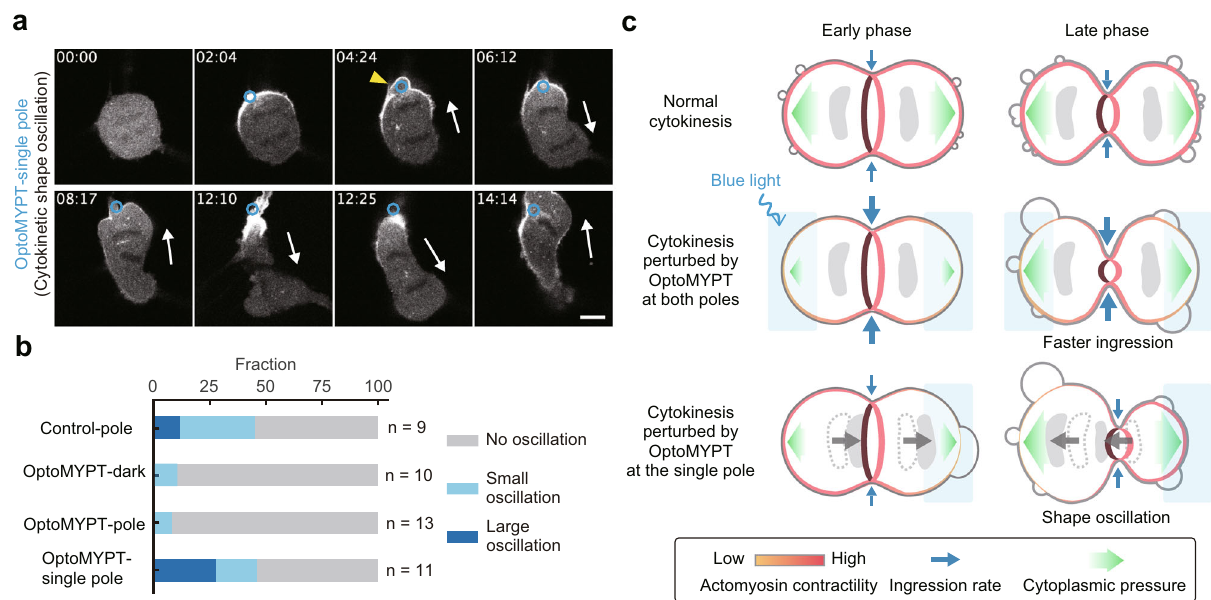
Fig. 5 OptoMYPT induced shape instability during cytokinesis. a Representative images of SspB-mScarlet-I-MYPT169 during cytokinesis upon illumination to the single pole. The blue circular regions were locally illuminated with blue light every 3.11 s. The yellow arrowhead and white arrow indicate a large bleb just before spindle oscillation and the direction of chromosome motion, respectively. Scale bar, 10 μ m. b Quanti fi cation of the fraction of the cytokinetic dynamics under the indicated conditions. The small oscillation and large oscillation are de fi ned as a slight oscillation of the spindle and an oscillation of two daughter chromosomes entering one of the cells, respectively. c Schematic model of mechanical regulation of the contractile ring and the actin cortex during cytokinesis. In control cells, high cortical tension acts as a decelerator of the ring constriction. The high cortical tension and cytoplasmic pressure induce blebbing from the early phase of cytokinesis. The increased cytoplasmic pressure associated with ring constriction in the late phase is released by the increased number of blebs. In OptoMYPT-expressing cells illuminated by blue light at both poles, bleb formation is suppressed in the early phase of cytokinesis and the cleavage furrow ingression is accelerated due to the decrease in the cortical tension. As cleavage furrow ingression progresses, large blebs emerge due to the increased cytoplasmic pressure in the late phase of cytokinesis. In OptoMYPT-expressing cells illuminated by blue light at a single pole, the reduced cortical tension at one side leads to the formation of a large bleb and the cytoplasmic fl ow. The retraction of the bleb induces cell shape oscillation accompanied with the back-and-forth movement of